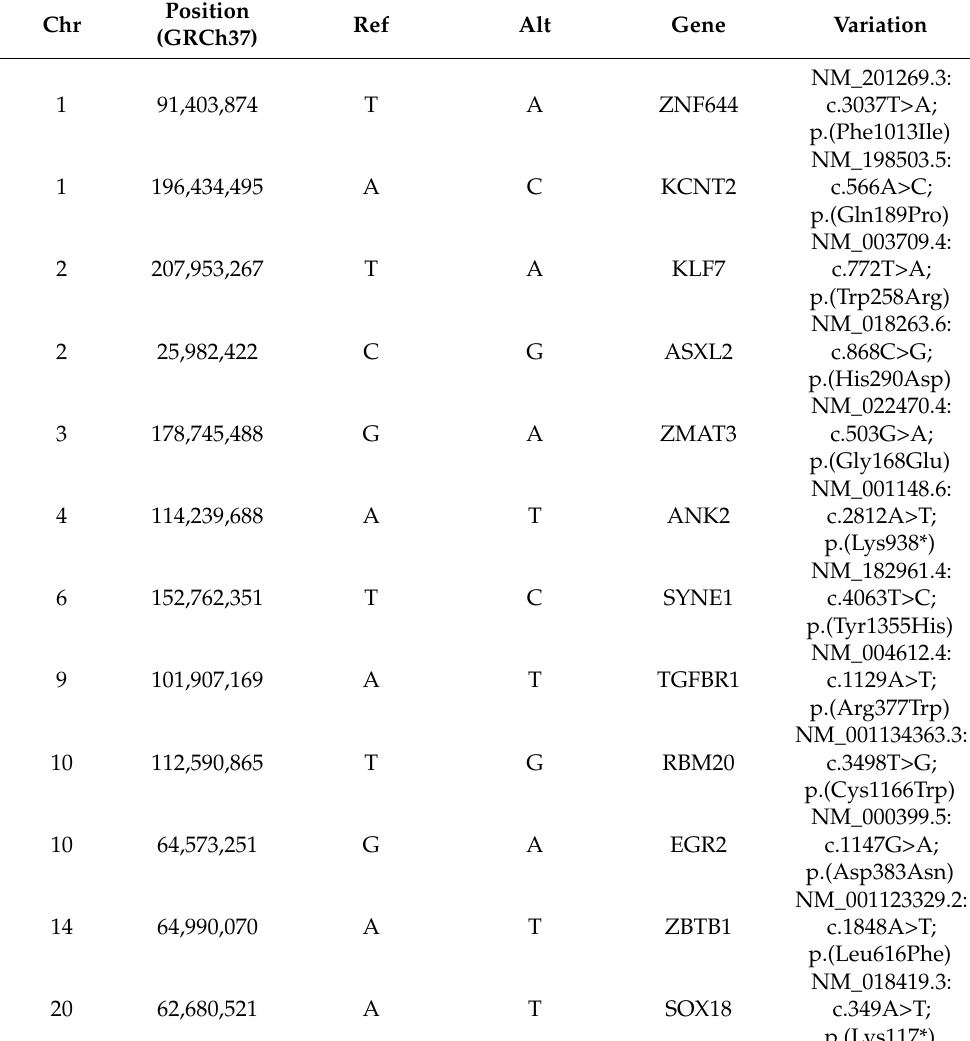
Table 2. Nonsynonymous variations located in the candidate genes for congenital cardiovascular anomaly identified by whole-exome sequencing and bioinformatics analysis. Position Ref Alt Gene Chr (GRCh37)